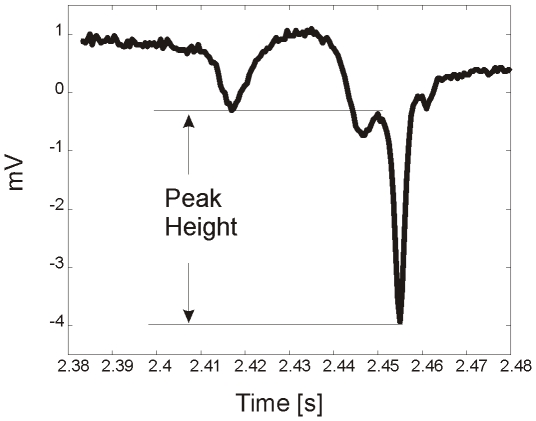
An R spike indicating how the amplitude measurement was made.